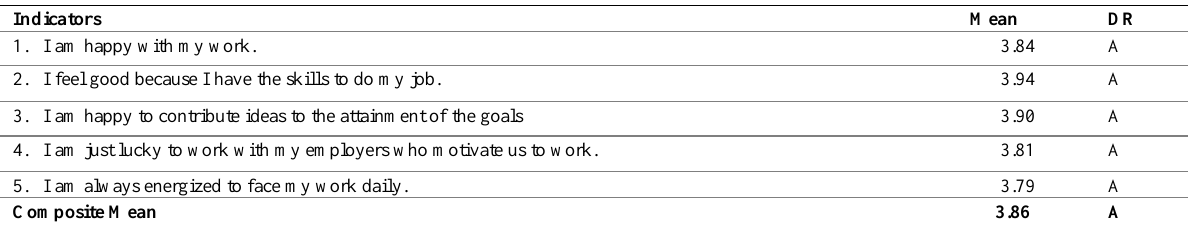
Table 9: The Work Engagement of Employees of Divine Word Colleges in the Ilocos Region in terms of Emotional/Psychological (Affective)